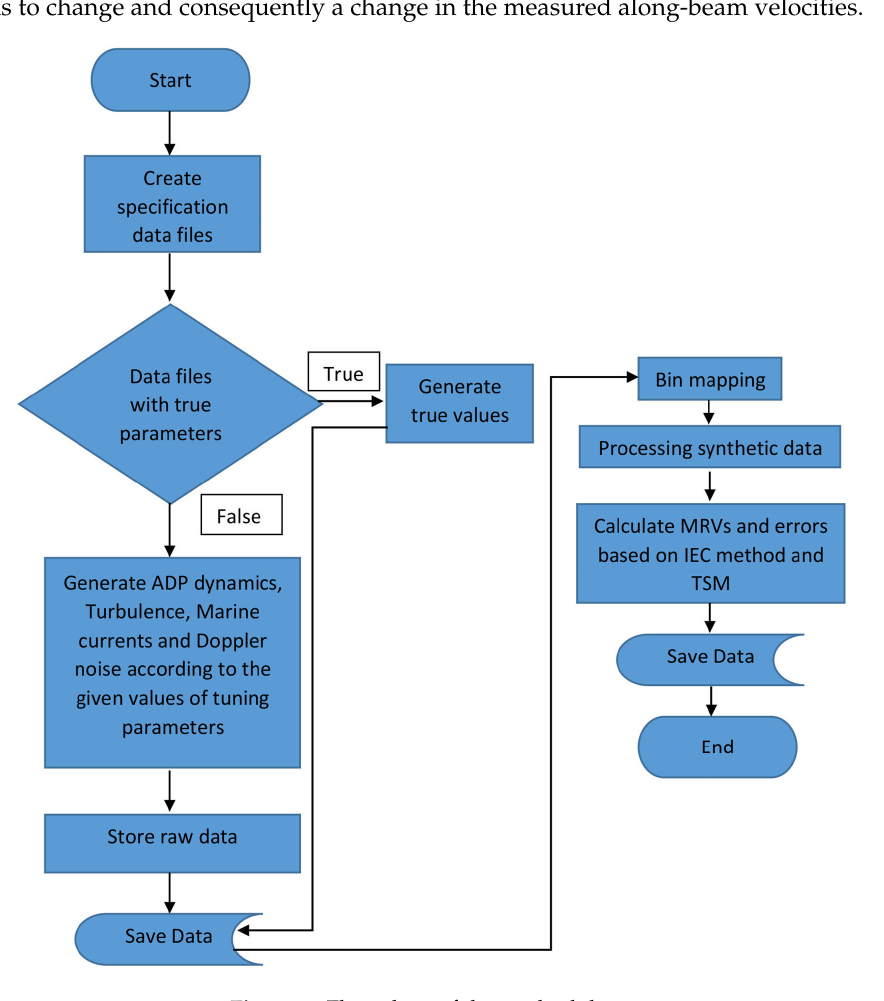
Figure 1. Flow chart of the methodology.